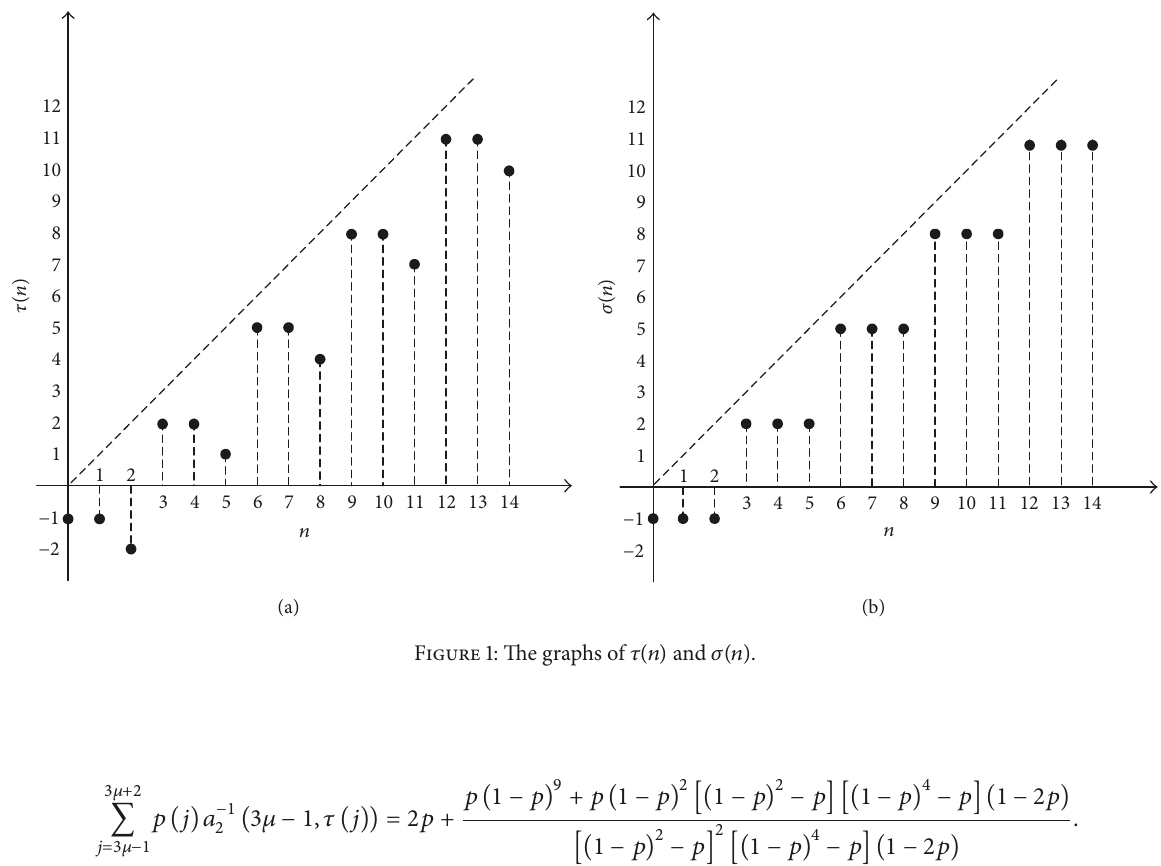
Figure 1: The graphs of 𝜏(𝑛) and 𝜎(𝑛)